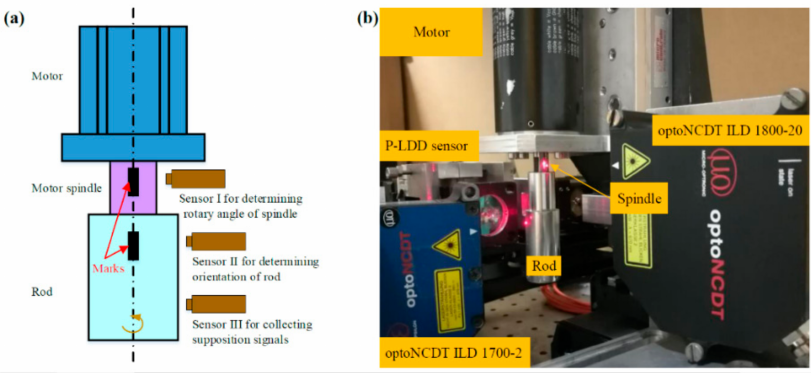
Figure 64. ( a ) Schematic diagram of the measurement apparatus and ( b ) its physical photo